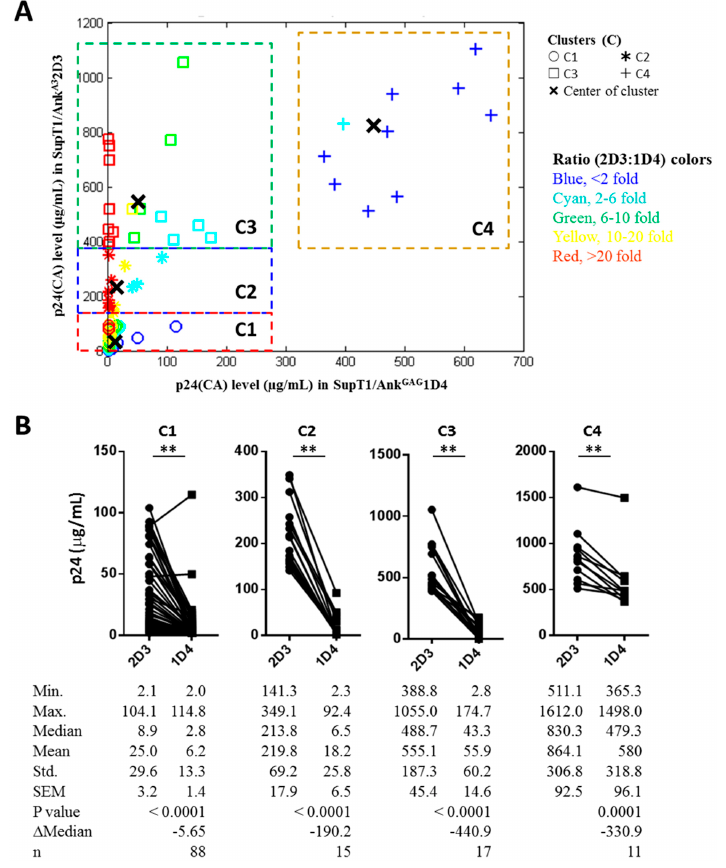
Figure 3. Quantitative analysis of the p24CA levels of the four clusters. ( A ) Four clusters, namely C1, C2, C3, and C4, were classified by the K-means clustering method. In the case of C4, a dataset in which the p24CA levels of SupT1/Ank GAG 1D4 and SupT1/Ank A3 2D3 were over 1500 µg/mL was excluded from the plot. ( B ) The p24CA level of the four clusters after being classified by the K-means clustering method. Significant differences (** p < 0.01) in the p24CA levels between SupT1/Ank GAG 1D4 and SupT1/Ank A3 2D3 were determined using the two-tailed Wilcoxon matched-pairs signed-rank